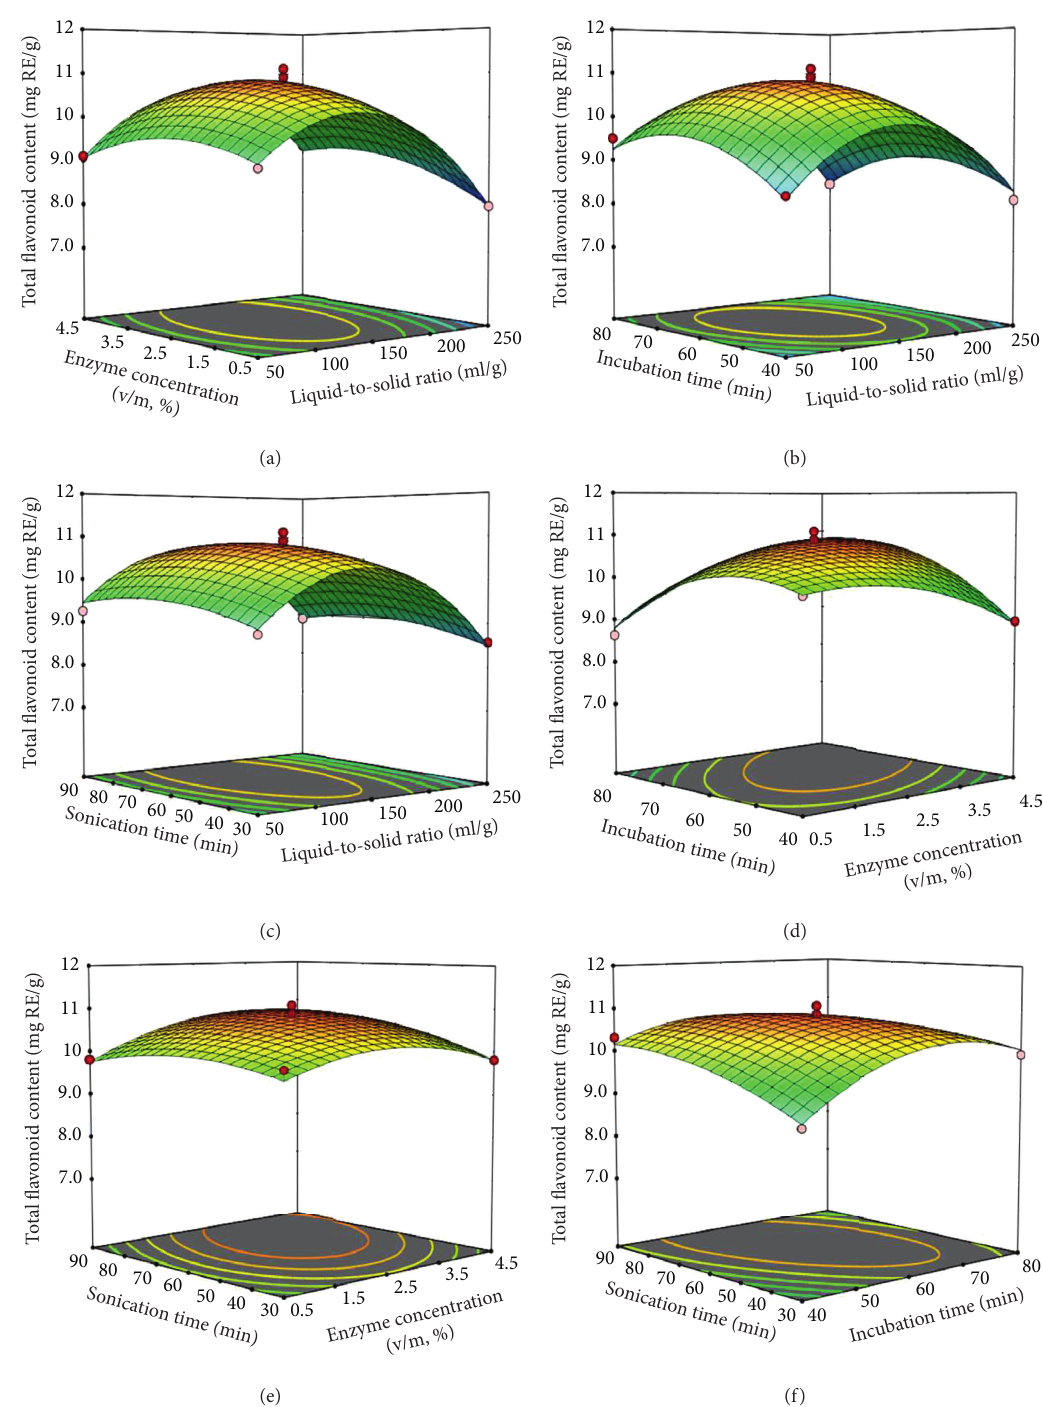
Figure 1: Response surface plots (3D) showing the effects of different extraction parameters on extraction yield of flavonoids from Da Xanh pomelo peel (a) at varying liquid-to-solid ratio and enzyme concentration, (b) at varying liquid-to-solid ratio and incubation time, (c) at varying liquid-to-solid ratio and ultrasonic time, (d) at varying enzyme concentration and incubation time, (e) at varying enzyme concentration and ultrasonic time, and (f) at varying incubation time and ultrasonic